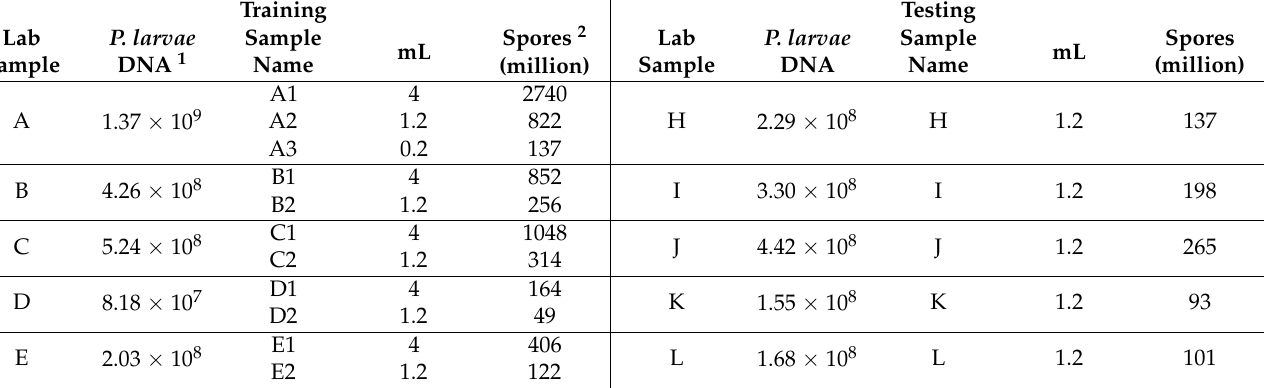
Table 2. Concentration of P. larvae DNA and approximate spore numbers in the training and testing samples. Spore samples A–F were used in training, with the same sample used at several volumes, e.g., sample A was first used at 4 mL (A1) and then reduced to 1.2 mL (A2). Four control samples (N–Q) were divided into 7 controls for training. Spore samples H–M were used in the trials, along with control samples R–Y which were divided into 21 controls at 1.2 mL each. − : none detected by qPCR. 1 copies of P. larvae DNA per mL, 2 See methods for calculation of approximate number of P. larvae spores per